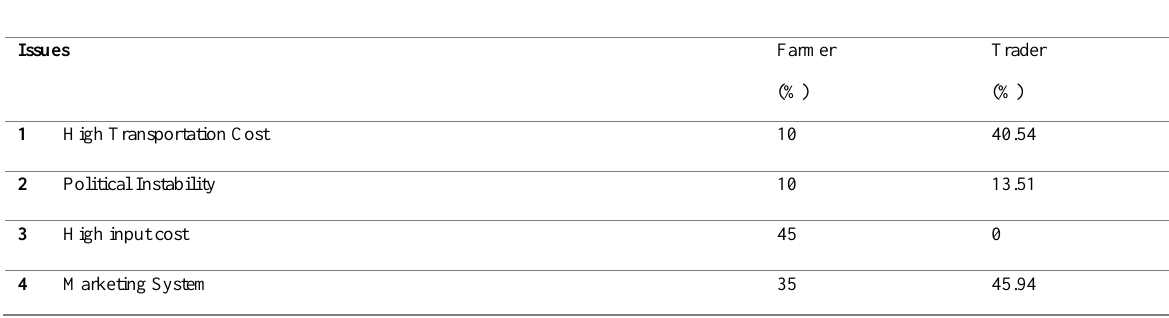
Table 5: Causes of Price Variation between Farmers to Retail